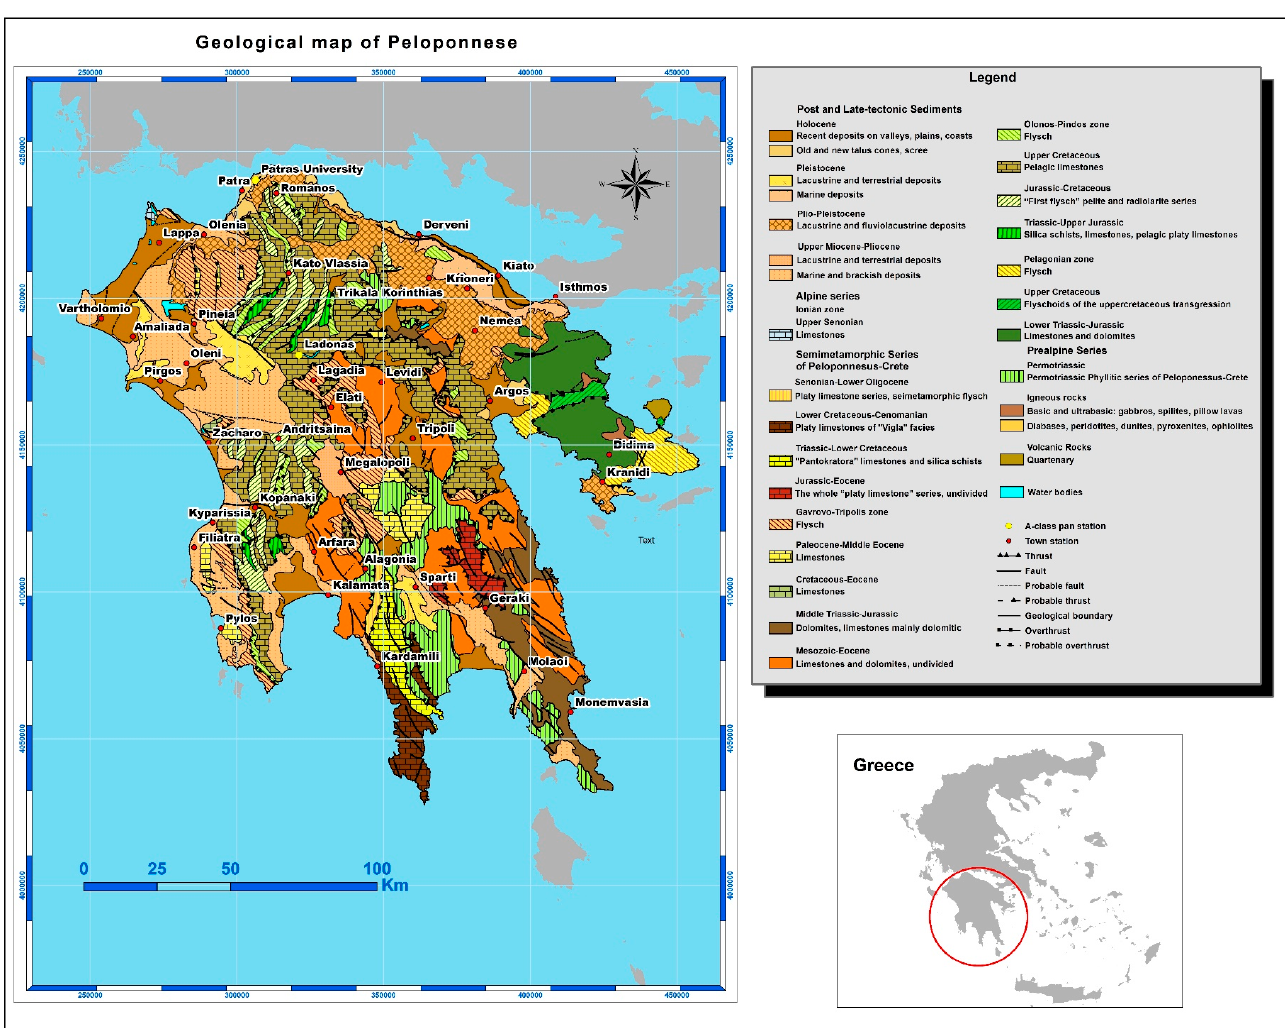
Figure 2. Geological formations of the Peloponnese (Digitized from [63]. Adapted with permission from ref. [63]. 1999, ©